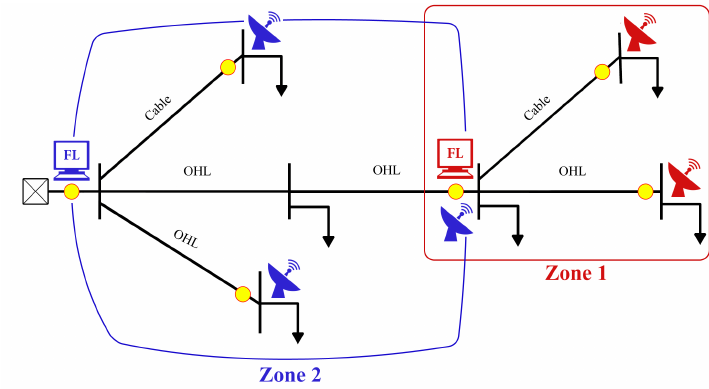
Figure 3. Overall schematic of the fault location method. FL, fault locator; OHL, overhead line.